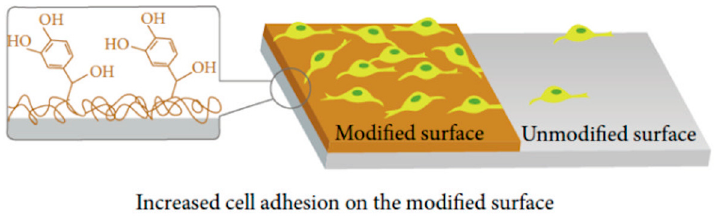
Figure 10. Surface modification through melanin-like coatings obtained by polymerization of norepinephrine promotes adhesion of human stem cells on obtained biointerfaces. Reproduced with permission from [35]. Copyright Hindawi Publishing Corporation, 2014.